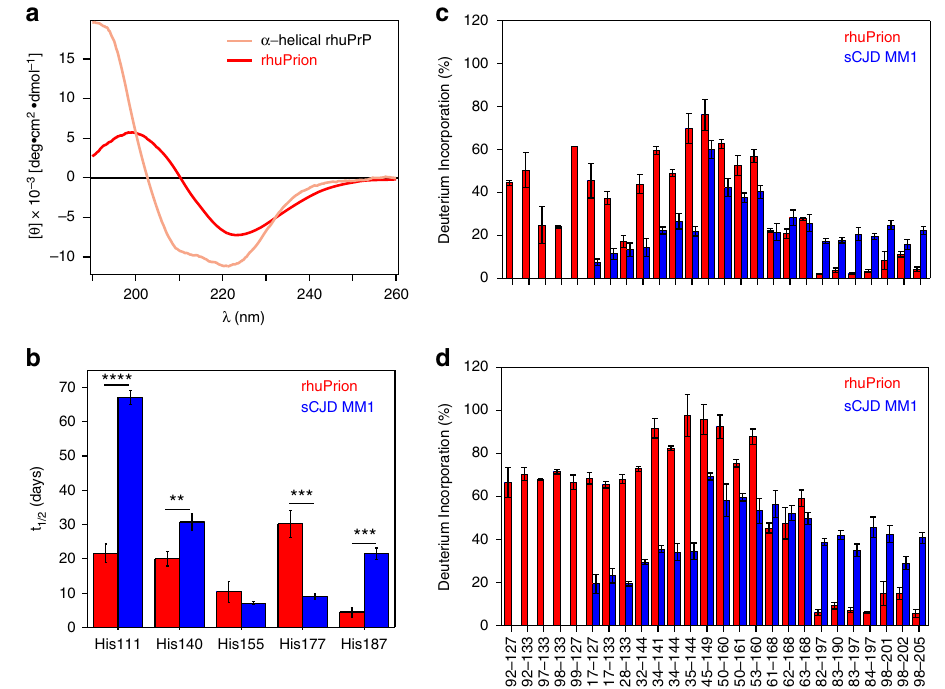
Fig. 1 Structural comparison of rhuPrion and brain-derived sCJD MM1 PrP Sc used as an initial seed. a Far UV circular dichroism (CD) spectrum of recombinant human PrP monomer used as a QuIC substrate, and rhuPrion. b Histidine H/D exchange (His-HXMS) for rhuPrion (red) and MM1 rPrP Sc (blue). The parameter t 1/2 represents the half-time of exchange reaction for individual His residues. Error bars indicate standard deviation (3 independent experiments). ** p < 0.01; *** p < 0.001. c , d Backbone amide H/D exchange (HXMS) data for peptic fragments derived from rhuPrion (red) after 5 min ( c ) and 24 h ( d ) incubation in D 2 O. For comparison, previously published data are included for sCJD MM1 rPrP Sc (blue) data after 5 min ( c ) and 10 days ( d ) incubation in D 2 O 16 . Error bars indicate standard deviation (3 independent experiments). * p < 0.05; ** p <